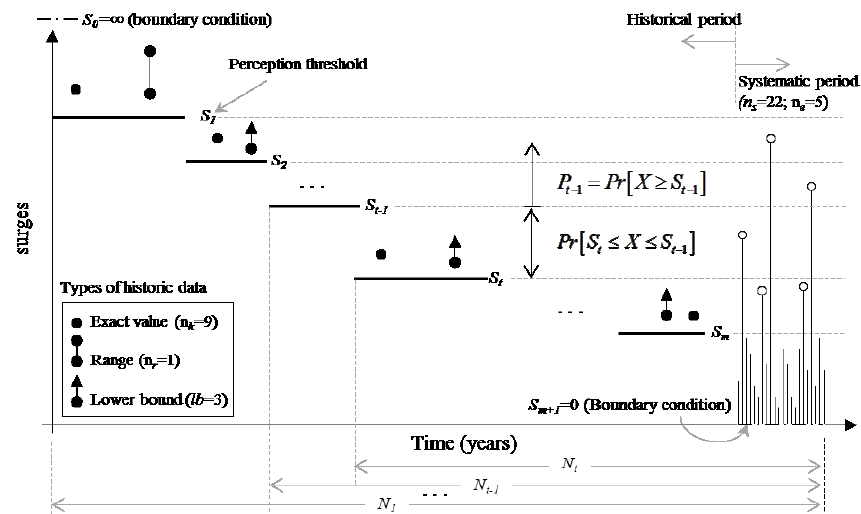
Figure 2. A sketch of systematic records and historical information: a multiple-threshold case.